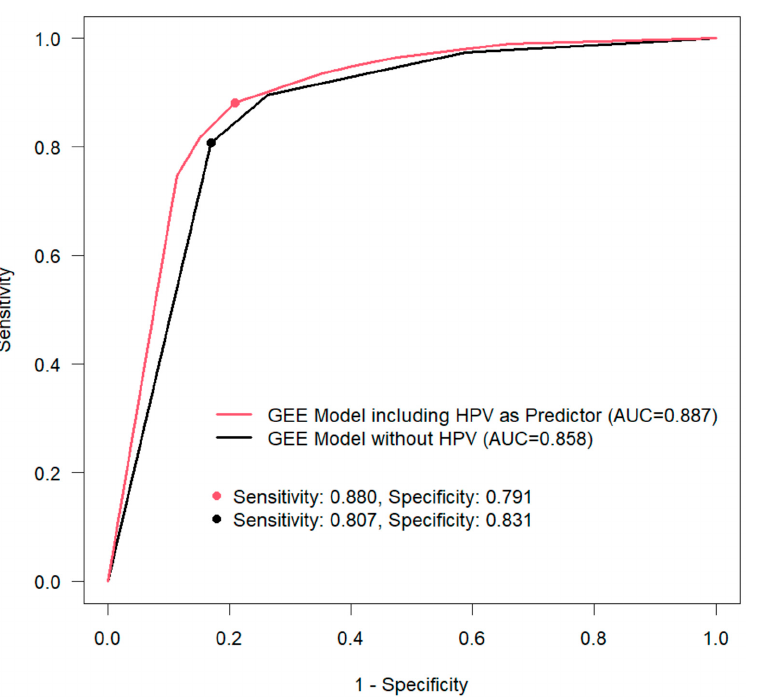
Figure 2. The generalized estimating equation (GEE) model, with and without HPV as a predictor. AUC, area under the curve.